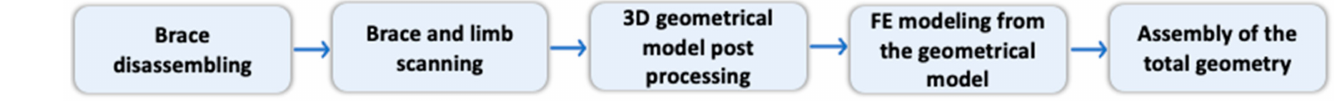
Figure 2. The workflow of the reverse engineering